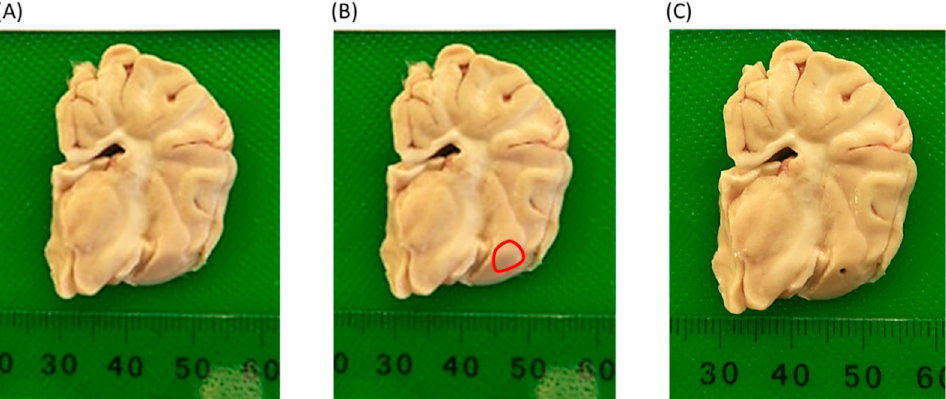
Figure 6. Sampling location for amygdala tissue, ( A ) Left hemisphere coronal section of pig brain with entire amygdala; ( B ) identification of amygdala (red circle), from pig atlas derived from Felix et al. [49]; ( C ) left hemisphere coronal section of pig brain with amygdala sample removed by punch biopsy.